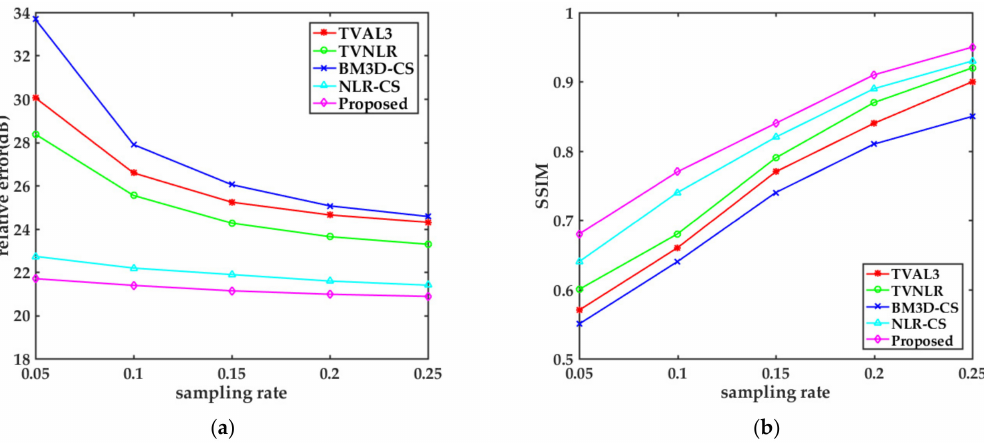
Figure 7. The ( a ) relative error(dB) and ( b ) SSIM of high frequency components of the Cameraman image at different sampling rates reconstructed by different